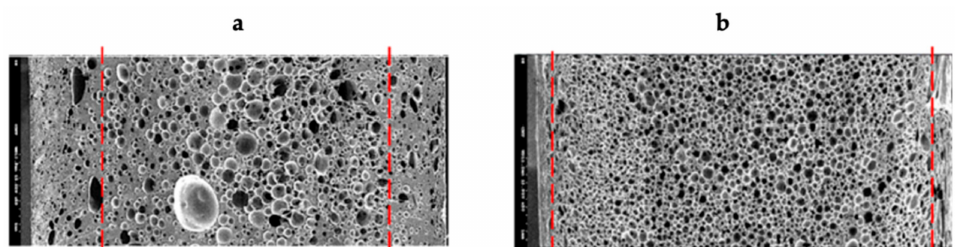
Figure 5. SEM images of the polyurethane foams without ( a ) and with ( b ) full temperature and pressure control